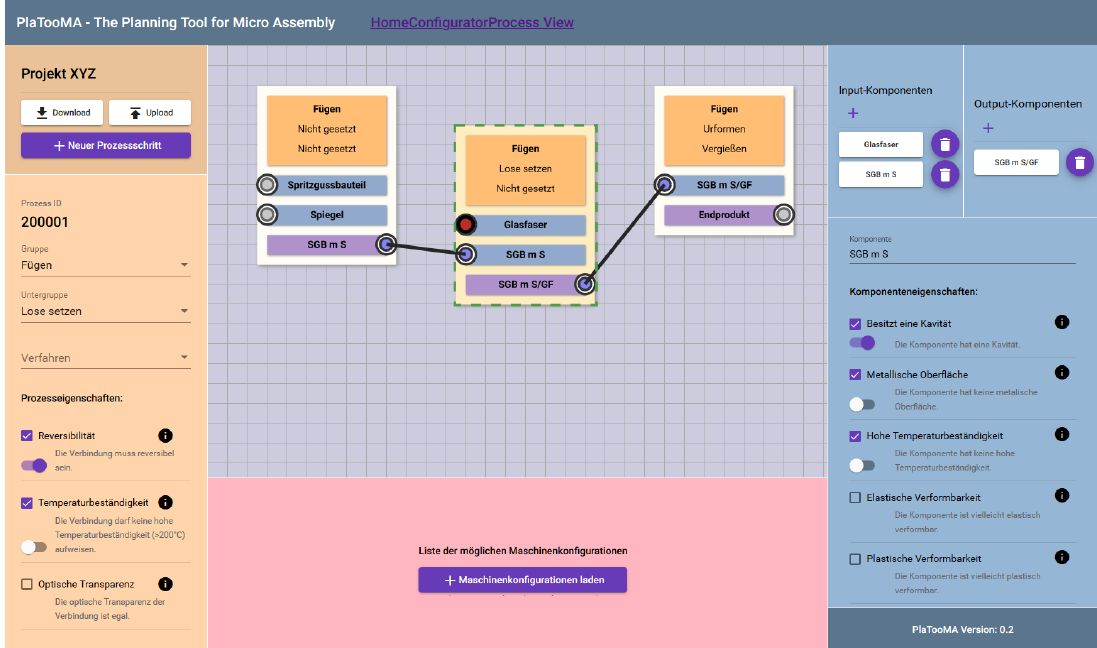
Figure 6. Screenshot of Configurator for PlaTooMA. At the grey canvas in the middle assembly steps can be added, arranged, and connected. The selected step is highlighted by a dashed green border. In the yellow area on the left, the procedure type and the process properties of the selected step can be set. In the blue area on the right, input and output components of the selected step can be added and deleted. Their properties can be modified as well. By clicking on the purple button in the red bottom area, fitting machine configurations can be